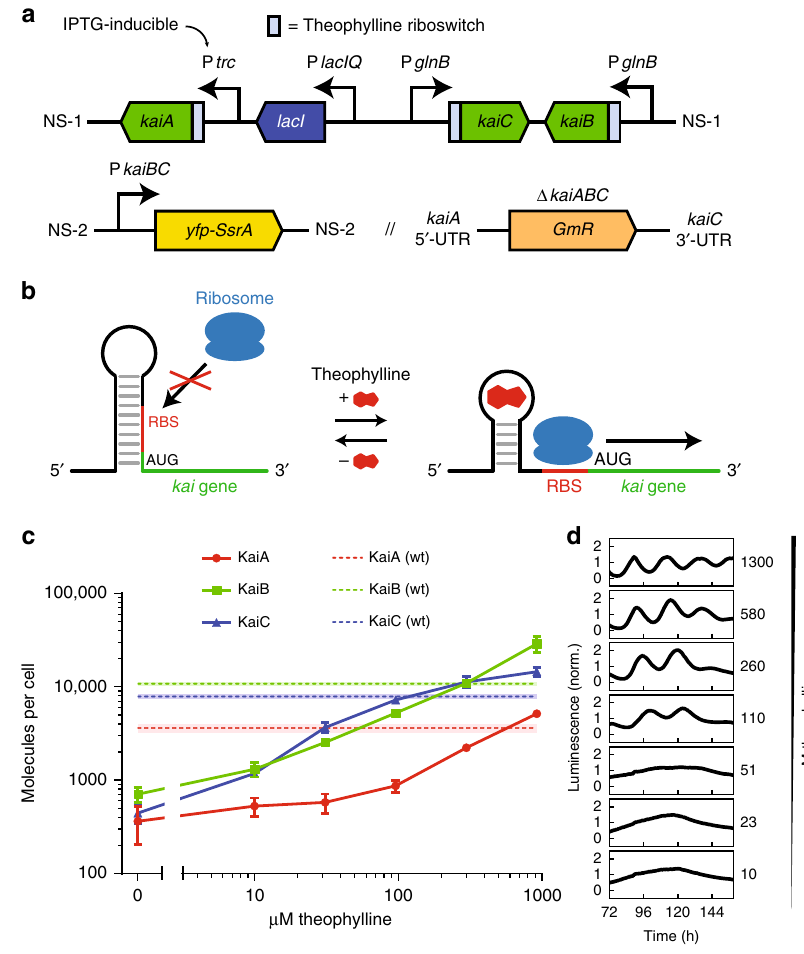
Fig. 1 Characterization of the Kai copy-number tunable strain. a A theophylline riboswitch regulates translational ef fi ciency of all three kai genes, and transcriptional regulation of kaiA is controlled by an IPTG-inducible promoter. Clock state is reported by EYFP-SsrA expressed from the kaiBC promoter. b Theophylline regulates translation by freeing the ribosome binding site upstream of each kai gene. c Kai copy numbers plotted as a function of theophylline concentration with 1 μ M IPTG (solid line), and Kai copy numbers in wild-type cells (dotted line). Vertical error bars or shaded area indicate standard error of the mean from three replicates. d Colony-level oscillations detected with a bioluminescent reporter in the copy number tunable strain with 1 μ M IPTG and various theophylline